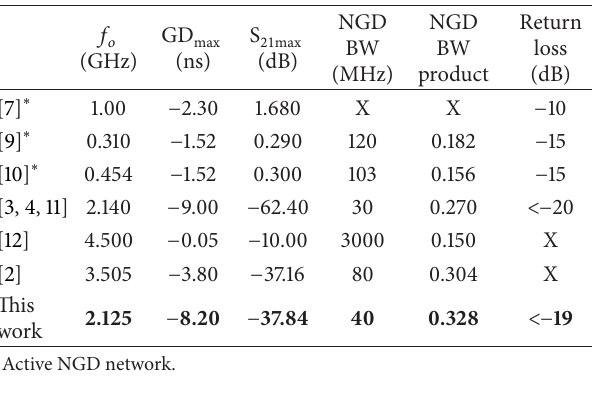
Table 1: Performance comparison of proposed NGD networks with conventional.